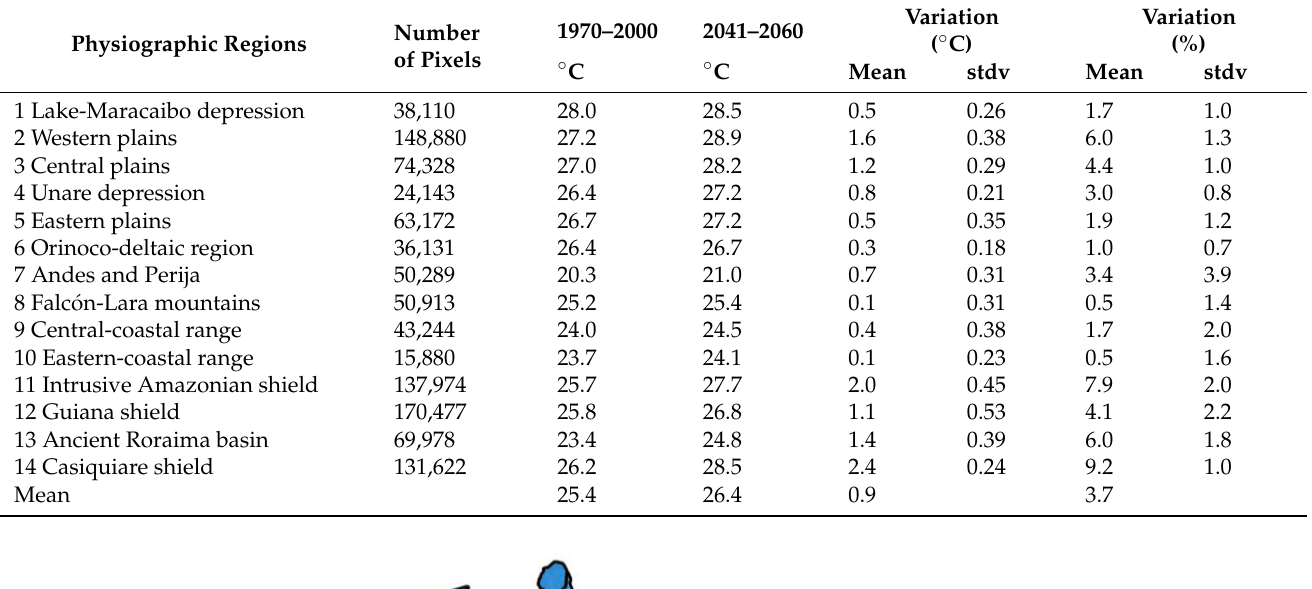
Table 1. Projected variation of annual mean temperature ( ◦ C) between 1970–2000 and 2041–2060 by physiographic regions.